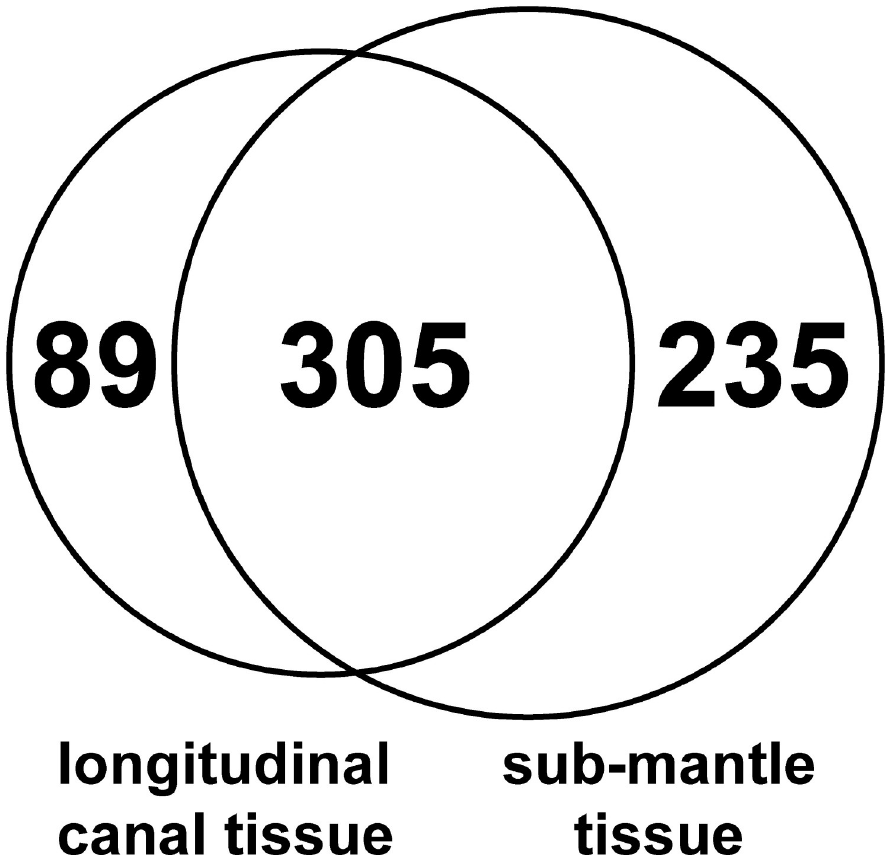
Fig 7. Venn diagram providing an overview of the protein profile of LCT and sub-mantle tissue. Out of a total of 629 identified proteins, 48% (305) were identified in both